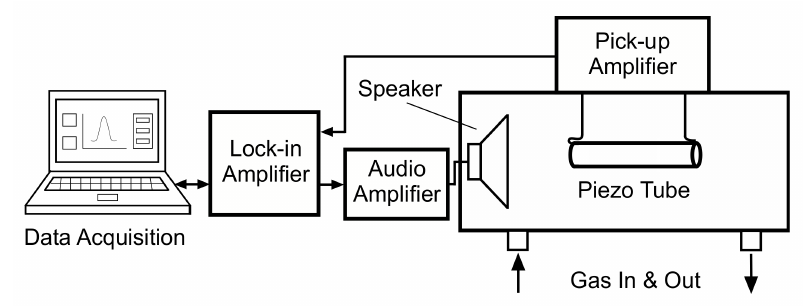
Figure 1. Schematic drawing of the piezo transducer set-up for evaluating the gases (not to scale).